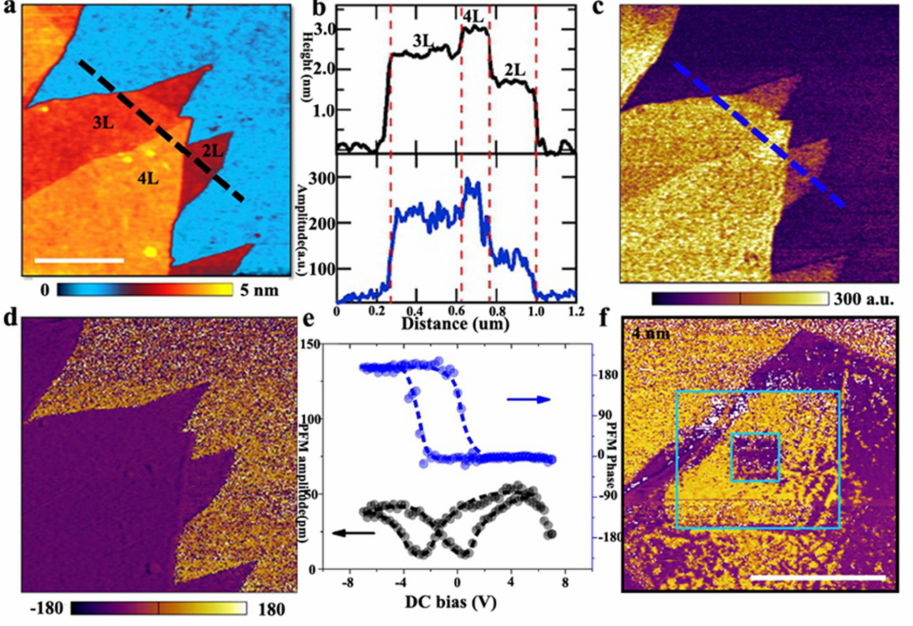
Figure 8. AFM topography ( a ) PFM amplitude ( c ) and phase ( d ) of 2–4 layer thick CIPS on Au coated SiO 2 /Si substrate. Scale bar in a, 500 nm. ( b ) the height (black) and PFM amplitude (blue) profile along the lines shown in a and c, respectively. L, layers. ( e ) The PFM amplitude (black) and phase (blue) hysteresis loops during the switching process for 4 nm thick CIPS flakes. ( f ) The PFM phase images for 4 nm thick CIPS flakes with written box-in-box patterns with reverse DC bias. Scale bar, 1 µ m. Adapted with permission from ref. [84], copyright: 2017,